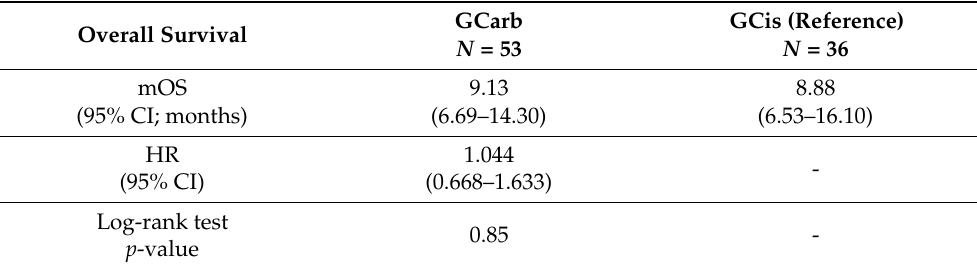
Table A4. Survival outcomes in patients receiving first line palliative chemotherapy including: gemcitabine and cisplatin (GCis) vs. gemcitabine and carboplatin (GCarb).